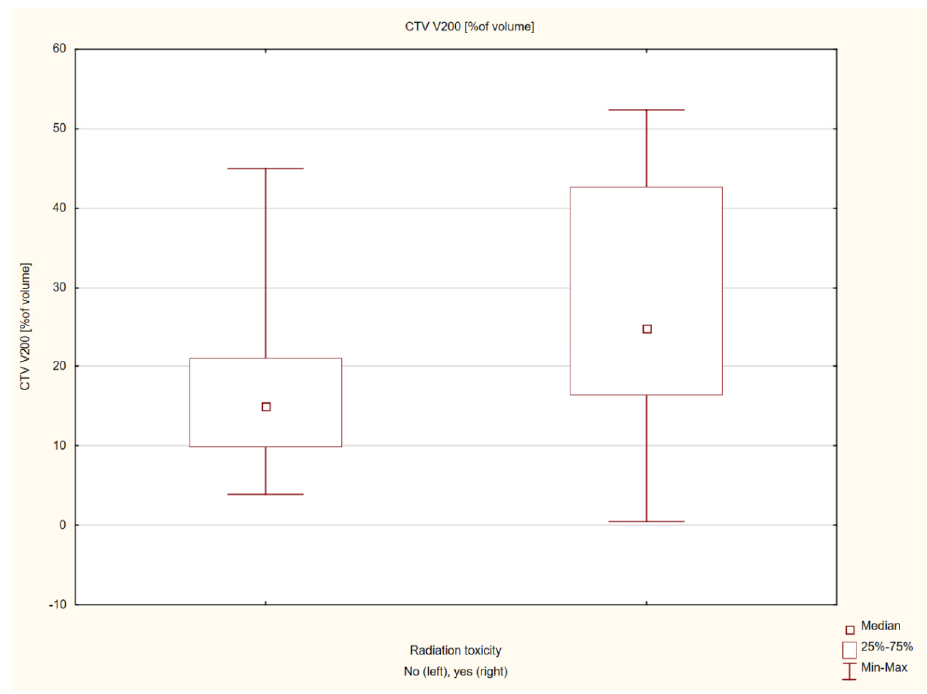
Figure 6. Analysis of the influence of the mean skin volume receiving the 200% dose on the severity of post-radiation reaction. Table 4. Influence of selected factors on the severity of radiation reaction on the basis of the Mann– tive